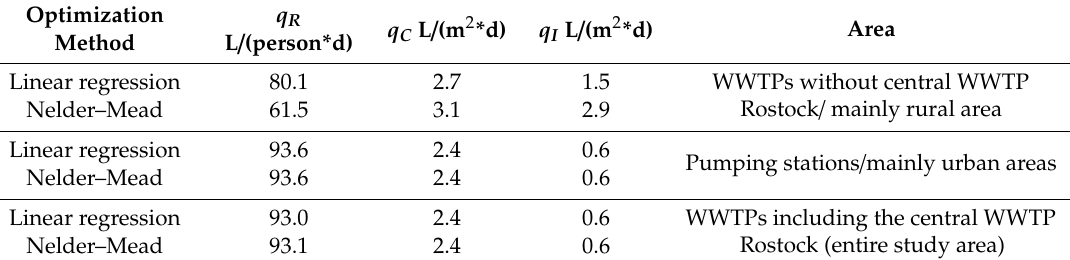
Table 2. Result of the parameter optimizing